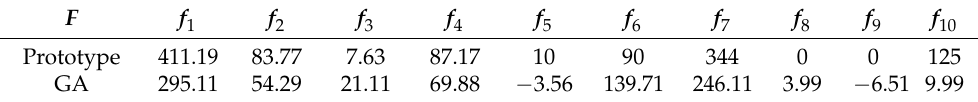
Table 8. Comparison between the existing prototype and the new proposal, units in mm.